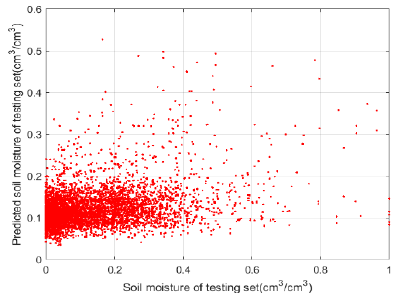
Figure 9. SVM classification with a testing dataset